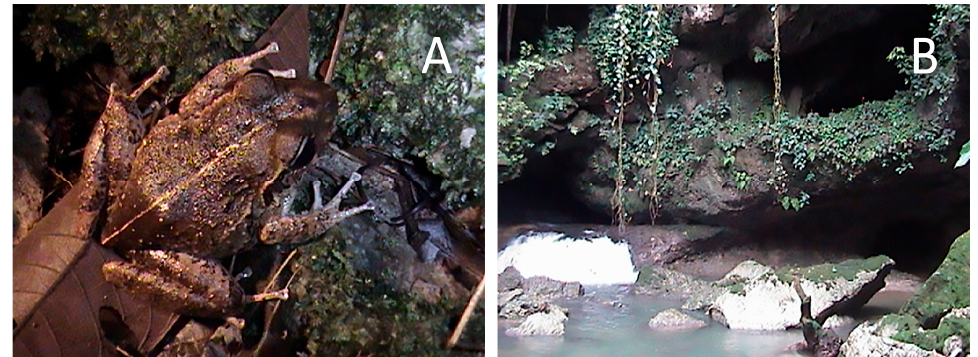
Figure 1. Adult individual of Craugastor pelorus ( A ) (CNAR-RF 763 a-b) found dwelling next to the underground river Iztac-Ha ( B ) (PEAB, Tabasco, Mexico). Photos by Omar Hernández